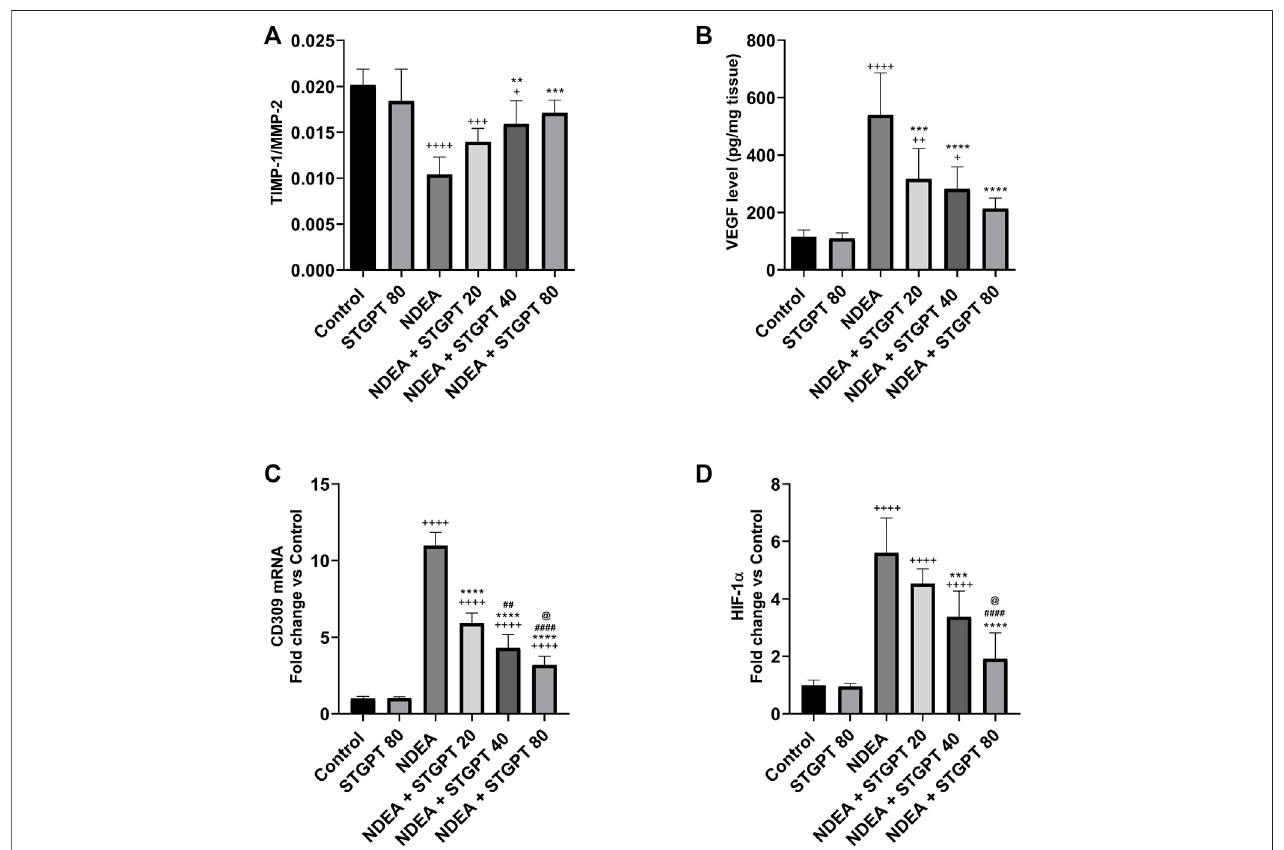
FIGURE 9 | Effect of STGPT (20, 40 and 80 mg/kg) on TIMP-1/MMP-2 ratio (A) ; VEGF (B) ; CD309 mRNA (C) ; and HIF1- α (D) in mice with NDEA-induced HCC. Dataarepresentedasthemean ± SD( n (cid:1) 6). + p < 0.05 vs. Controlgroup, ++ p < 0.01 vs. Controlgroup, +++ p < 0.001 vs Controlgroup, ++++ p < 0.0001vsControlgroup, ** p < 0.01 vs NDEA group, *** p < 0.001 vs. NDEA group, **** p < 0.0001 vs. NDEA group, ## p < 0.01 vs STGPT 20 group, #### p < 0.0001 vs. STGPT 20 group, @ p < 0.05 vs. STGPT40group.Control,normalcontrolgroupreceivedthevehicle;STGPT80,normalgroupreceivedsitagliptin(80 mg/kg);NDEA,NDEA-inducedHCC group received the vehicle; NDEA + STGPT 20, NDEA-induced HCC group treated with sitagliptin (20 mg/kg); NDEA + STGPT 40, NDEA-induced HCC group treated with sitagliptin (40 mg/kg); NDEA + STGPT 80, NDEA-induced HCC group treated with sitagliptin (80 mg/kg).